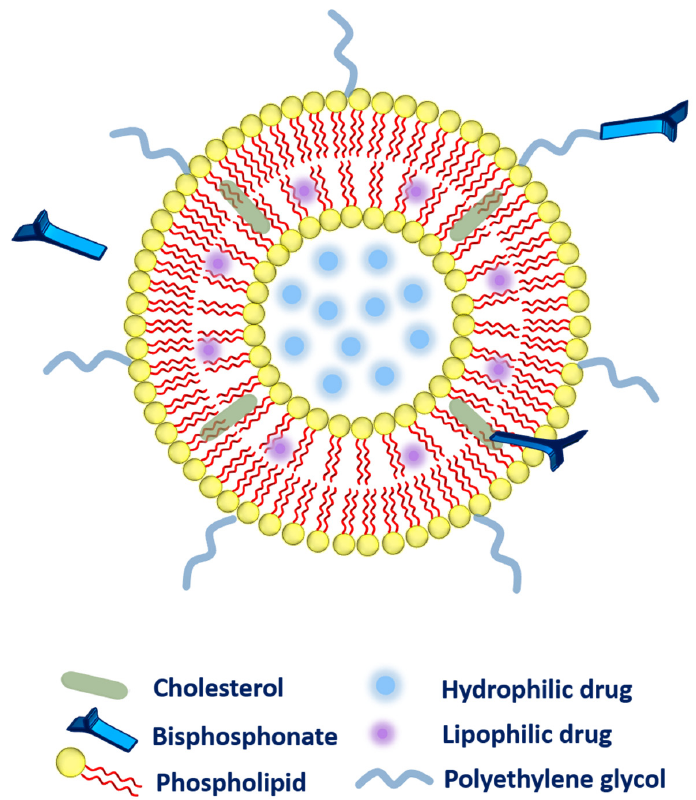
Figure 2. Different possibilities for the association of bisphosphonates with the liposomes.